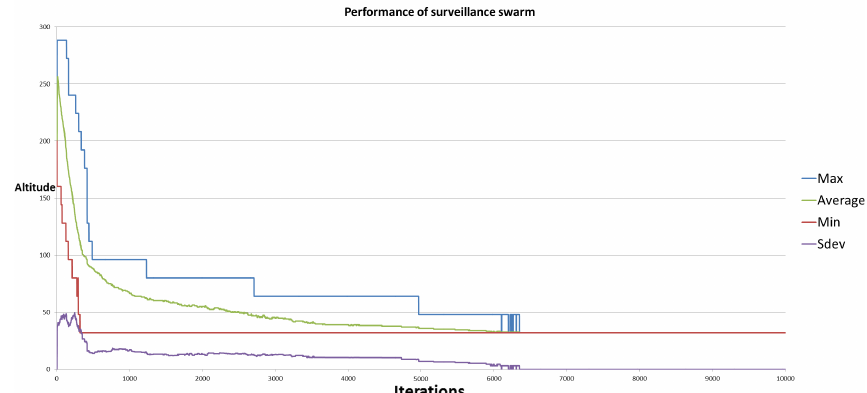
Figure 6. The coverage problem without requirements, baseline performance: homogeneous altitudes (best possible solution).